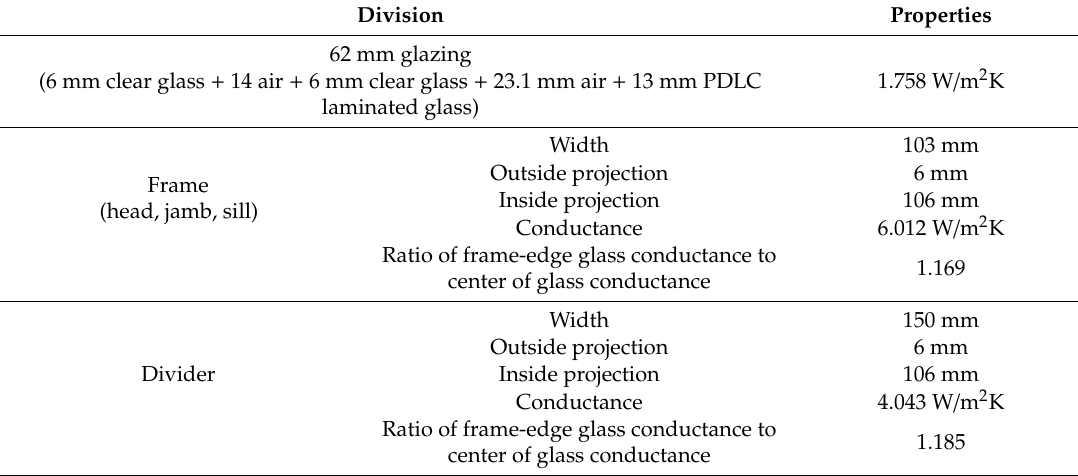
Table 15. Thermal properties of curtain wall by the application of attached PDLC window analysis